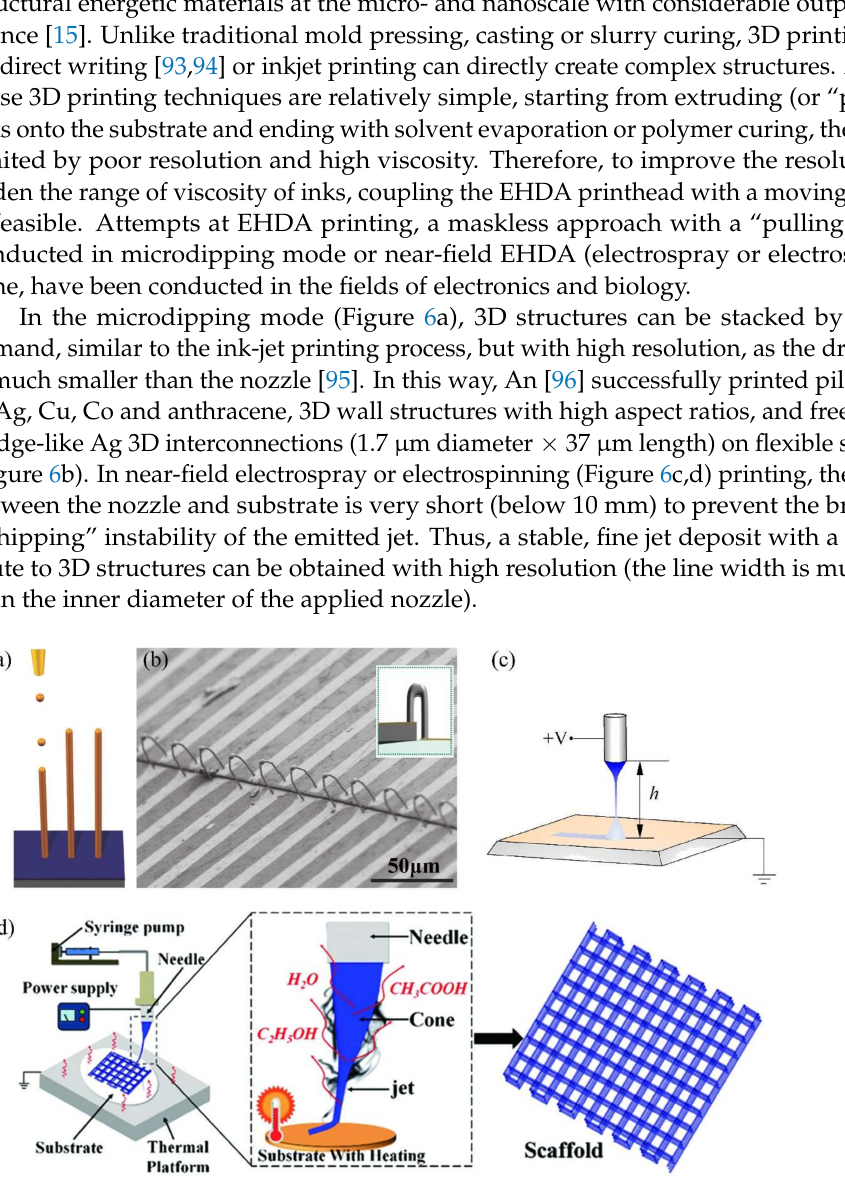
Figure 6. Schematic illustrations of EHDA printing based on ( a ) microdipping (electronic functional ink). Adapted with permission from Ref. [96]. Copyright 2015 Copyright John Wiley and Sons, ( c ) near-field electrospray (zinc oxide lines) [97] and ( d ) near-field electrospinning (biopolymer scaffold). Reprinted with permission from Ref. [98]. Copyright 2018 Copyright John Wiley and Sons. ( b ) SEM image and schematic (insert image) of bridge-like Ag interconnects printed from microdipping mode. Adapted with permission from Ref. [96]. Copyright 2015 Copyright John Wiley and